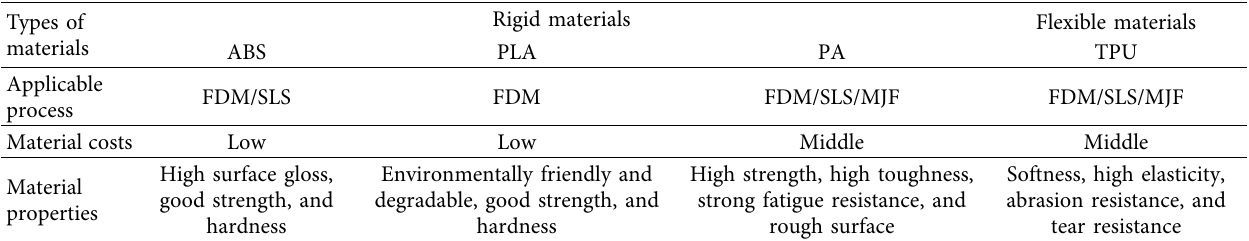
Table 6: Comparison of 3D printing